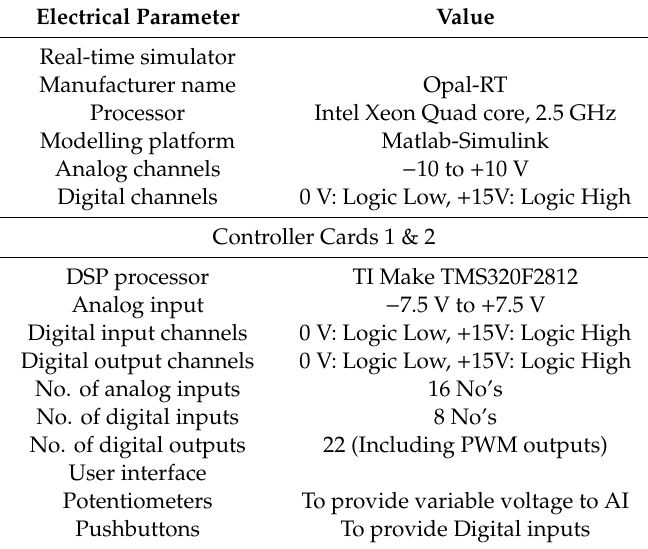
Figure 8. Controller-in-loop simulation setup. Table 4. Hardware details of real-time simulator setup.